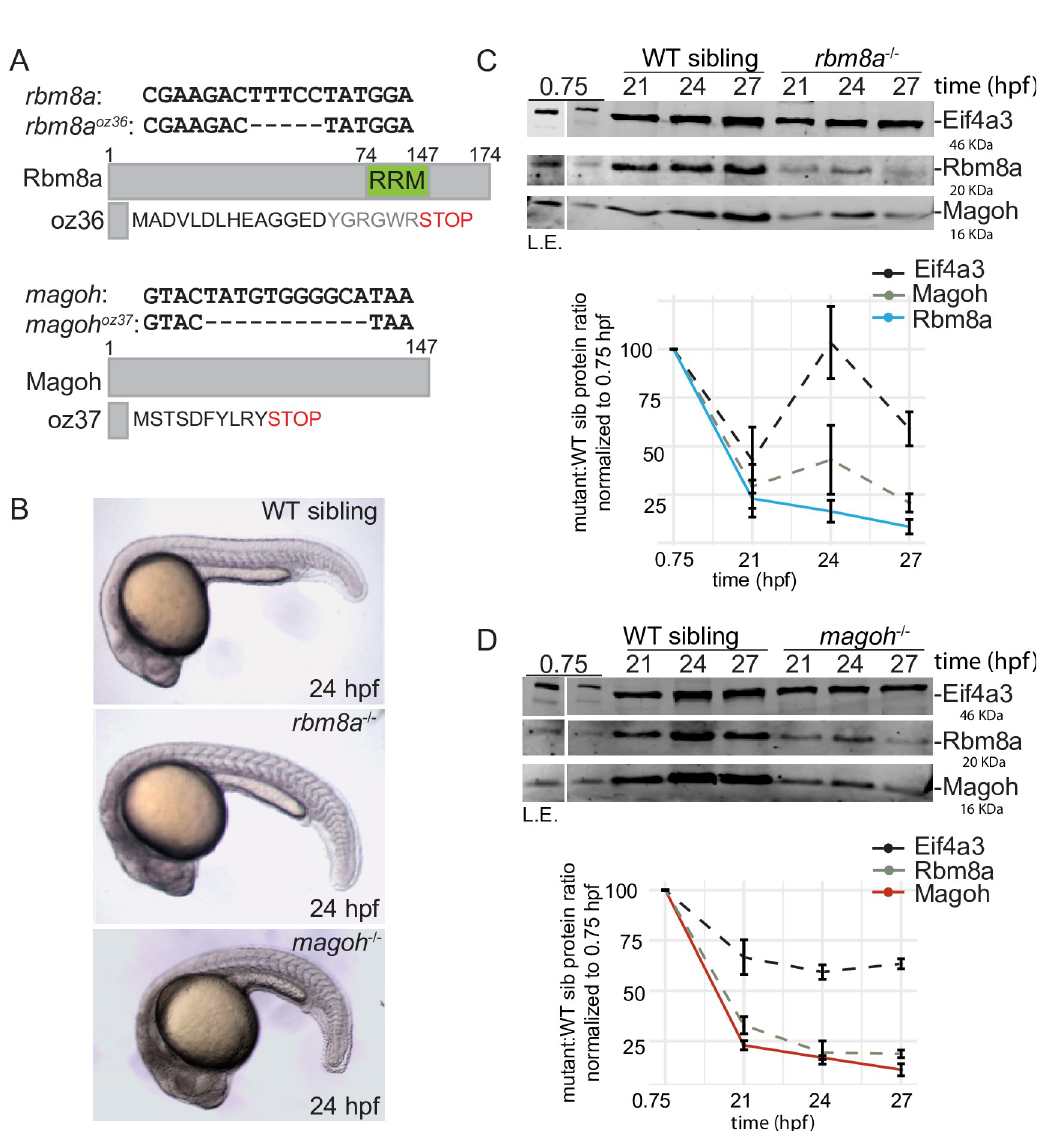
Fig 2. Zebrafish rbm8a and magoh mutant embryos show gradual loss of maternally contributed Rbm8a and Magoh proteins during early development. A. Schematic illustrating the rbm8a oz36 and magoh oz37 alleles and the predicted proteins they encode. Full-length Rbm8a and Magoh proteins are also shown. RRM: RNA Recognition Motif. B. Whole mount images of live wild-type sibling, rbm8a mutant, and magoh mutant embryos at 24 hpf. Increased grayness in the head region of homozygous rbm8a and magoh mutant embryos indicates cell death. C. Top: Western blots showing EJC protein expression in wild type (WT) sibling and rbm8a -/- mutant embryos. Antigens detected are listed on the right and embryo genotype is listed above the blot. Developmental time points (hpf) are indicated above each lane. Protein from five (0.75 hpf) or ten embryos (all other time points) was loaded in each lane. A longer exposure (L.E.) of the 0.75 hpf lane is on the left. Bottom: Line graphs showing the amount of protein (per embryo) in the mutant embryos compared to wild-type sibling as a percent of protein present at 0.75 hpf. Error bars represent standard error of means. D. Top: Western blots as in C showing EJC protein expression in wild type (WT) sibling and magoh -/- mutant embryos. Bottom: Line graphs showing protein quantification as in C.